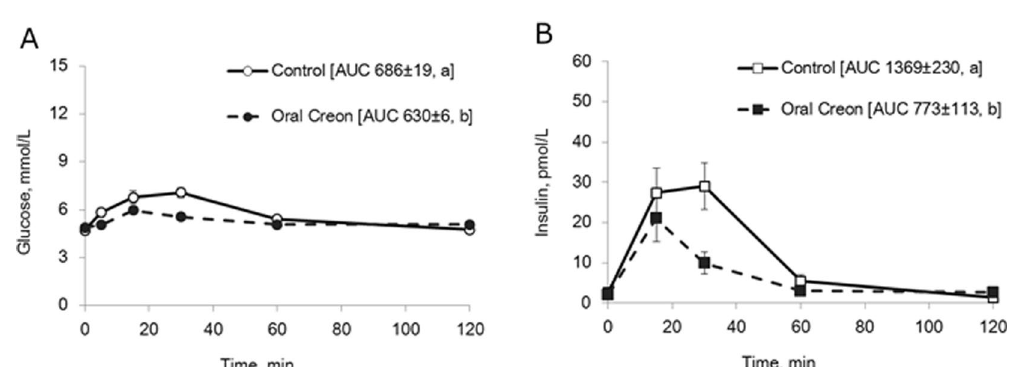
Figure 4. ( A , B ) Blood glucose ( A ) and plasma insulin concentrations ( B ) during a meal GTT without (control) and 1 h after oral enzyme (Creon ® ) treatment in healthy intact pigs. Data shown as mean ± SEM (n = 6) with AUC values shown in brackets. Different letters indicate statistically significant differences (p < 0.05) between control and enzyme treatment.